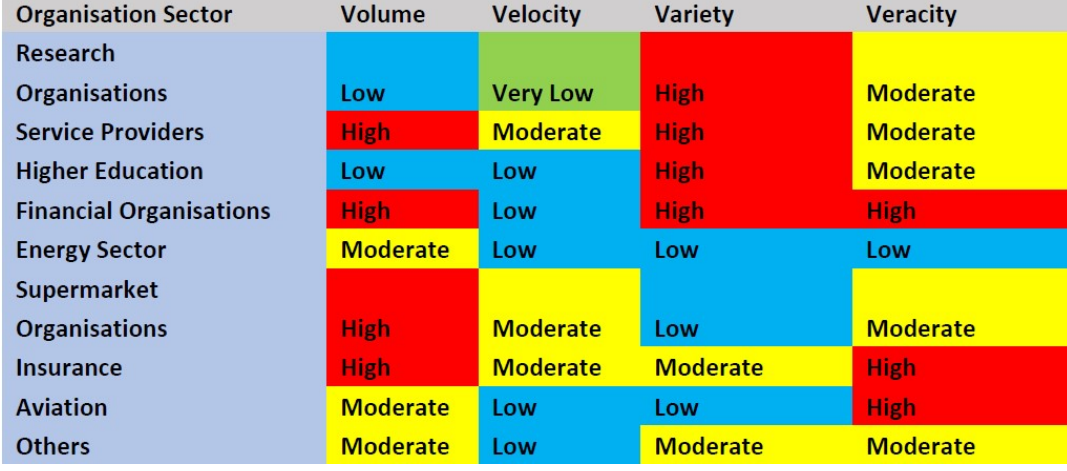
Figure 4. Range of data processing in organisations.